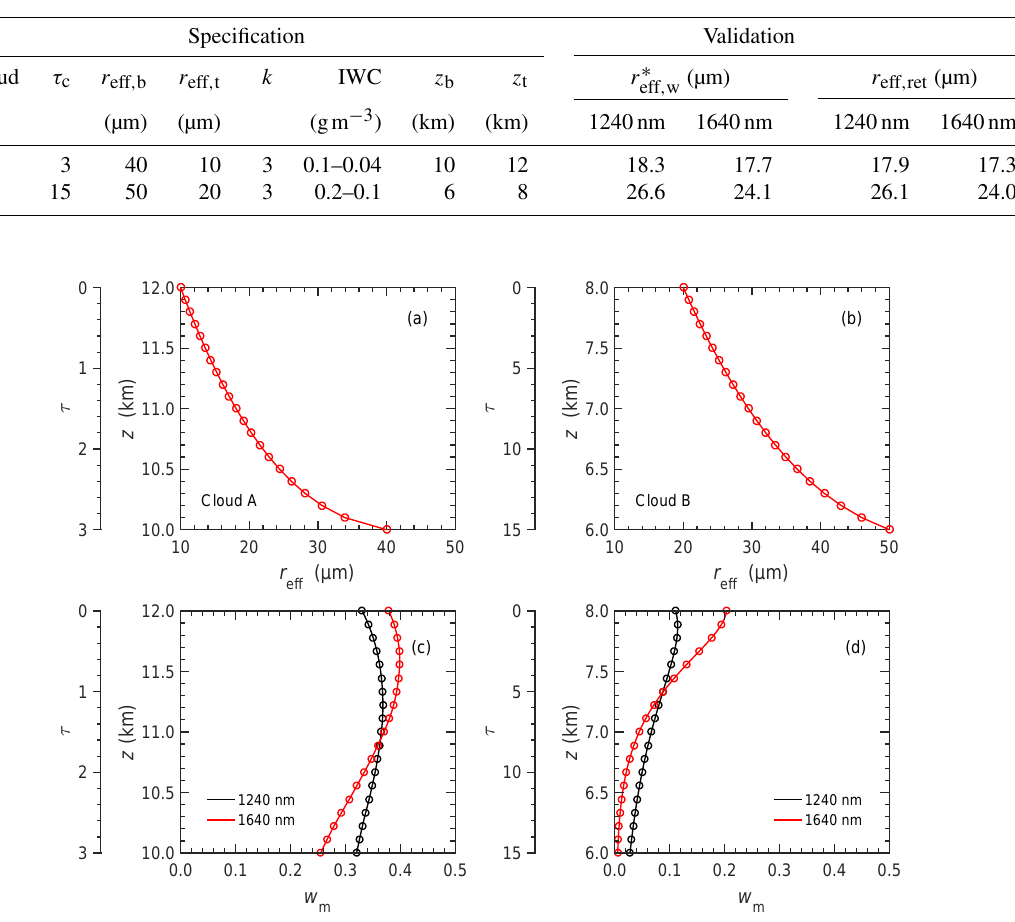
Figure 10. Panel (a) shows an analytic r eff profile of a cirrus (cloud A) while (b) is for a DCC composed of ice particles only (cloud B). Detailed specifications of the two analytic profiles are summarized in Table 3. Panel (c) is the w m calculated for cloud A at λ = 1240 and 1640nm, while (d) is for cloud